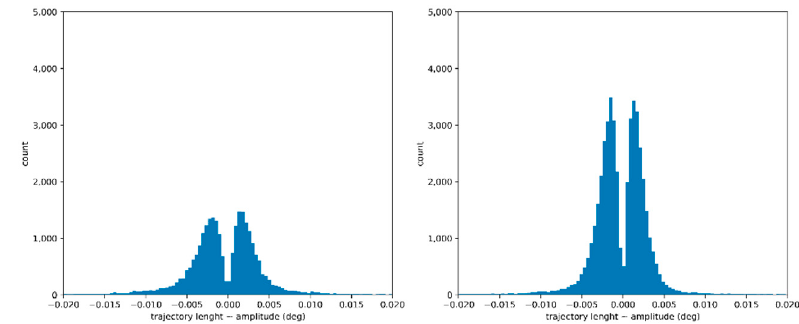
Figure A16. Histogram of the amplitude segments for the painting 5 data.